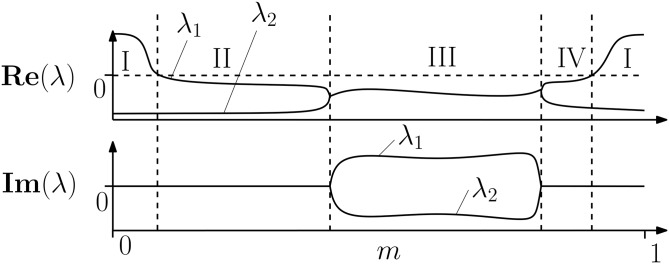
Schematic showing the evolution of two key eigenvalues along the entire length of the BM, i.e, for m ∈ [0, 1[.Note that λ1 has a positive real part in sub-domain I, which is negative in sub-domain II, III and IV. In sub-domain III λ1 is complex with the complex conjugate λ2. Due to the requirement of continuity, the local solution space associated with λ1 and λ2 must be spanned by v1 and v2 along the entire BM. Thus, the fact that one eigenvalue has a positive real part for only a portion of the BM, means that the motion corresponding to two eigenvalues must be spanned along the entire BM.